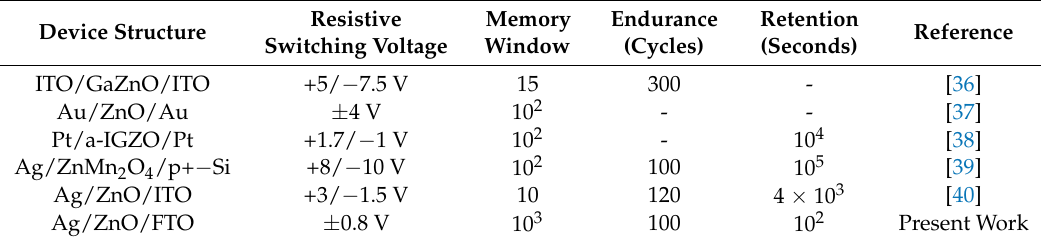
Table 1. Performance comparison of ZnO memristive devices.